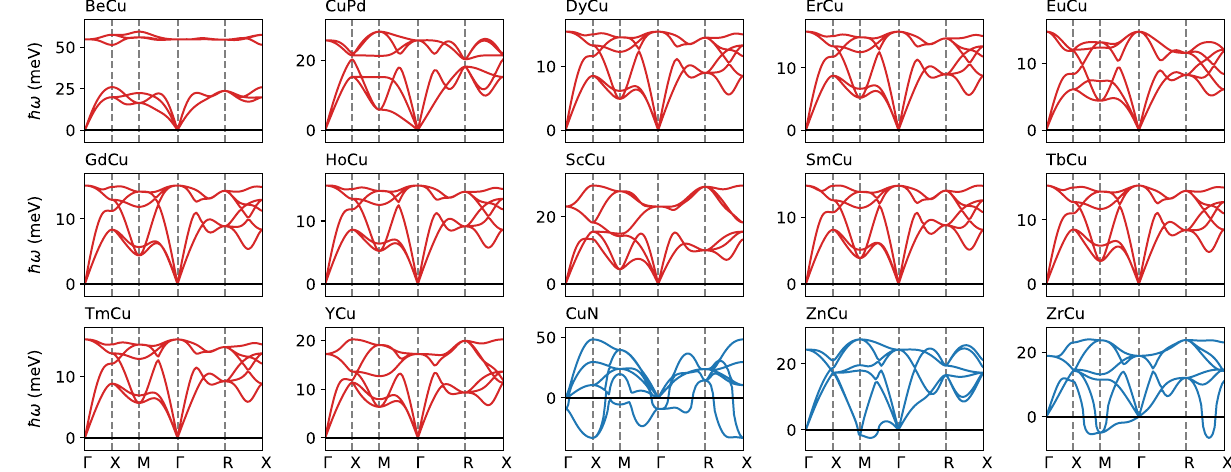
Figure 1. The phonon dispersions of the Cu-based B2 compounds. The dispersion curves are colored red and blue for the dynamically stable and unstable compounds,